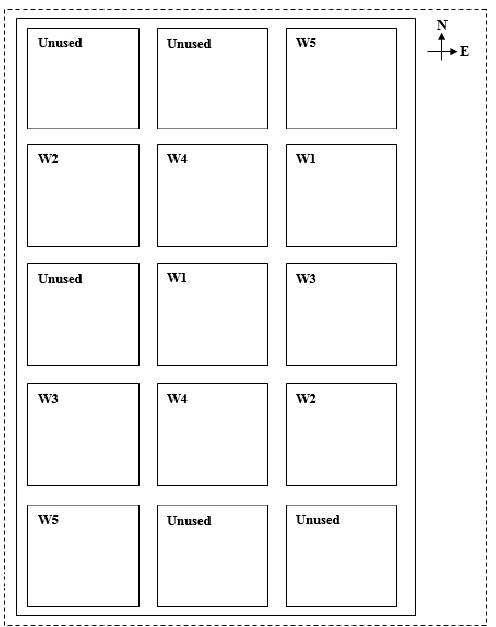
Figure A1. Layout of the experimental site. W1: 20% FC < SWC < 35% FC, W2: 35% FC < SWC < 45% FC, W3: 50% FC <SWC < 60% FC, W4: 65% FC < SWC < 75% FC, and W5: 80% FC < SWC < 90% FC.